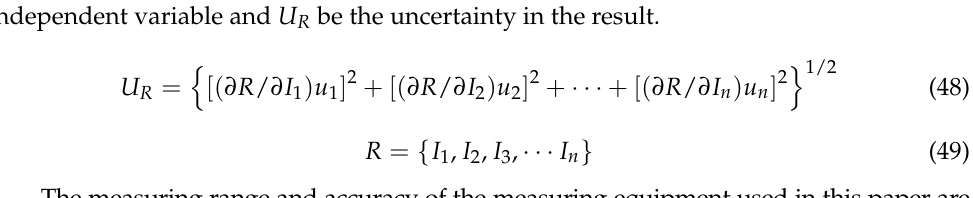
Table 4. Uncertainty of measured parameters.